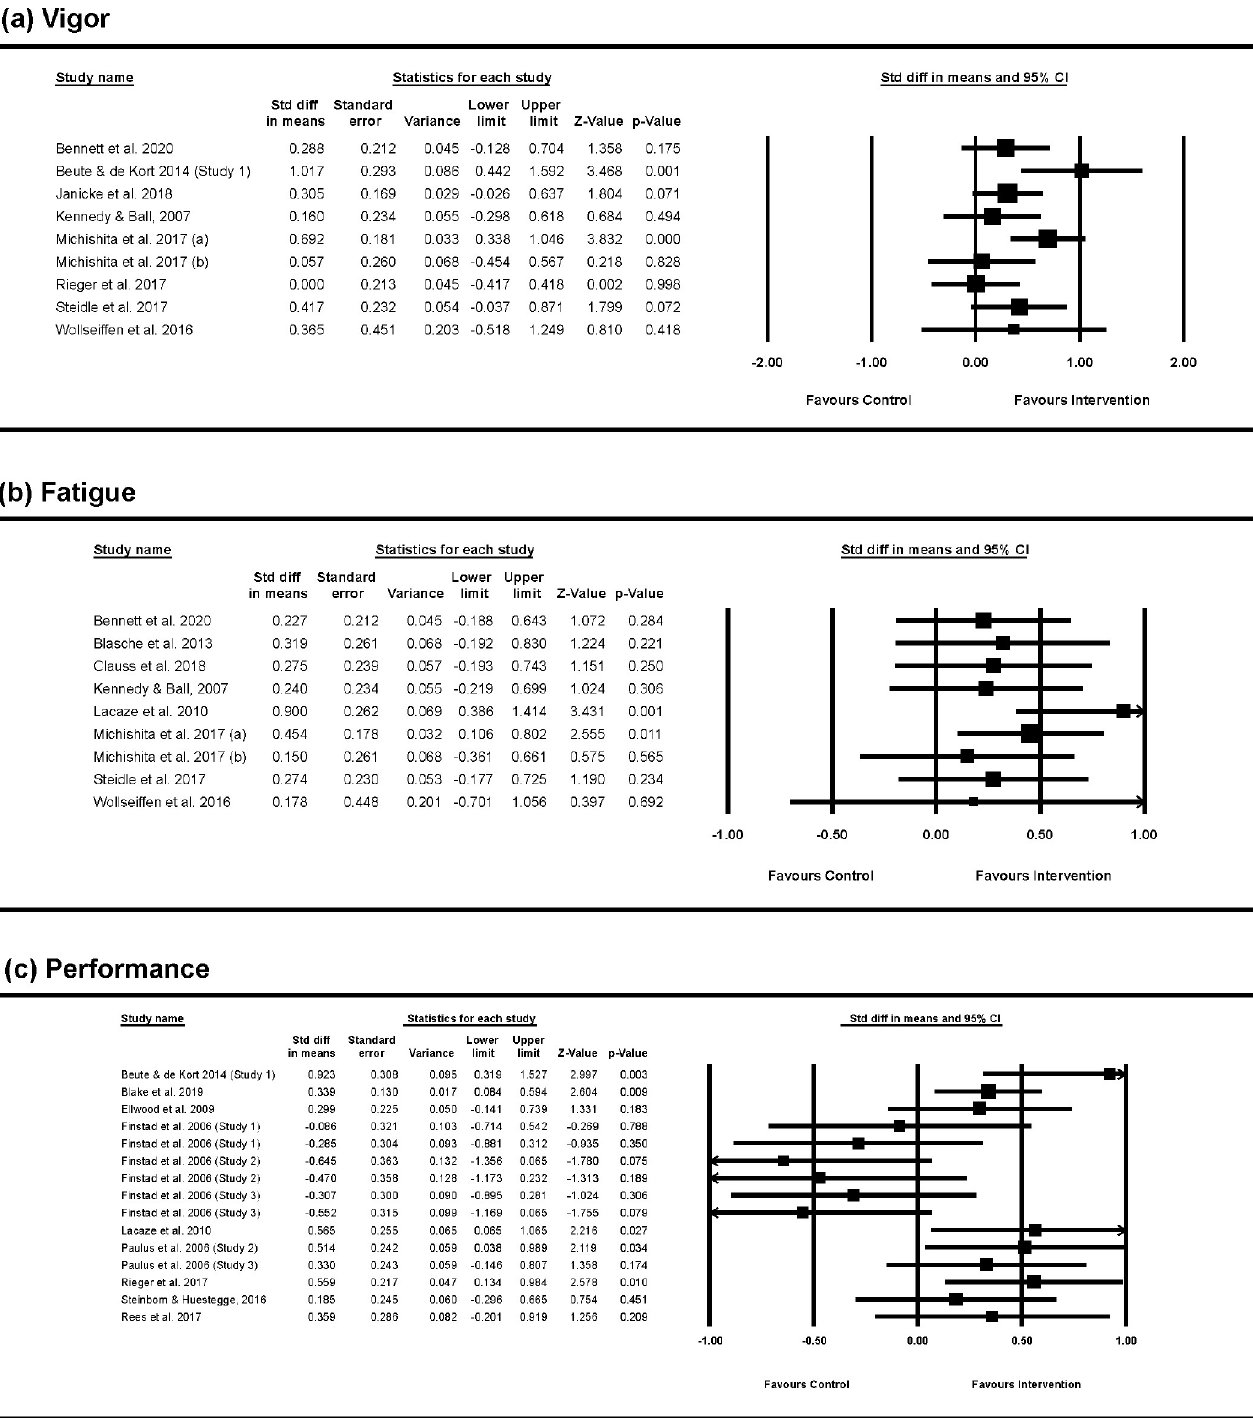
Fig 3. Standardized effect sizes and forest plot for the sample of studies regarding (a) Vigor, (b) Fatigue, and (c) Performance.